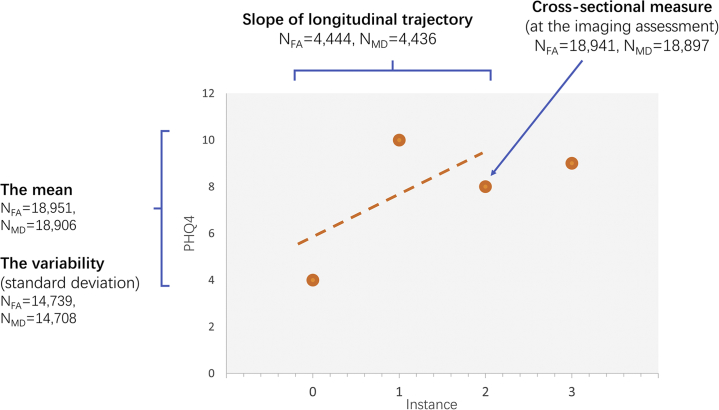
The measures for depressive symptoms generated for this study. The x-axis represents each instance (0 = baseline, 1 = first repeated assessment, 2 = imaging assessment, and 3 = online follow-up, consistent with the coding for instances in UK Biobank [http://biobank.ctsu.ox.ac.uk/showcase/instance.cgi?id=2]). There were 4 measures generated: 1) cross-sectional measurement for depressive symptoms acquired with imaging assessment, 2) linear growth curve denoting longitudinal trajectory of depressive symptoms derived from 3 time points up until the imaging assessment, 3) mean of depressive symptoms generated based on at least 2 multiple assessments, and 4) variability of depressive symptoms, which was the SD of at least 3 time points. FA, fractional anisotropy; MD, mean diffusivity; PHQ4, Patient Health Questionnaire-4.